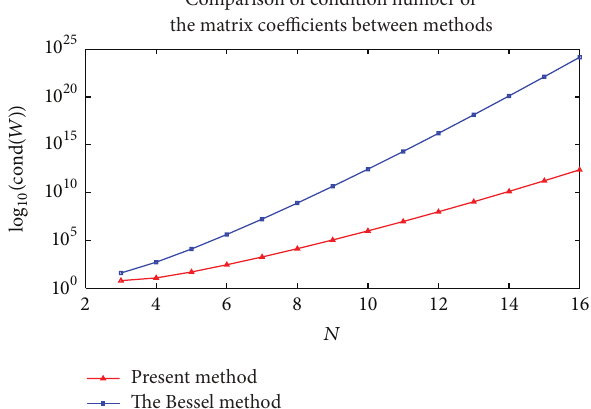
Figure 3: Condition number comparisons between our method and the Bessel method of Example